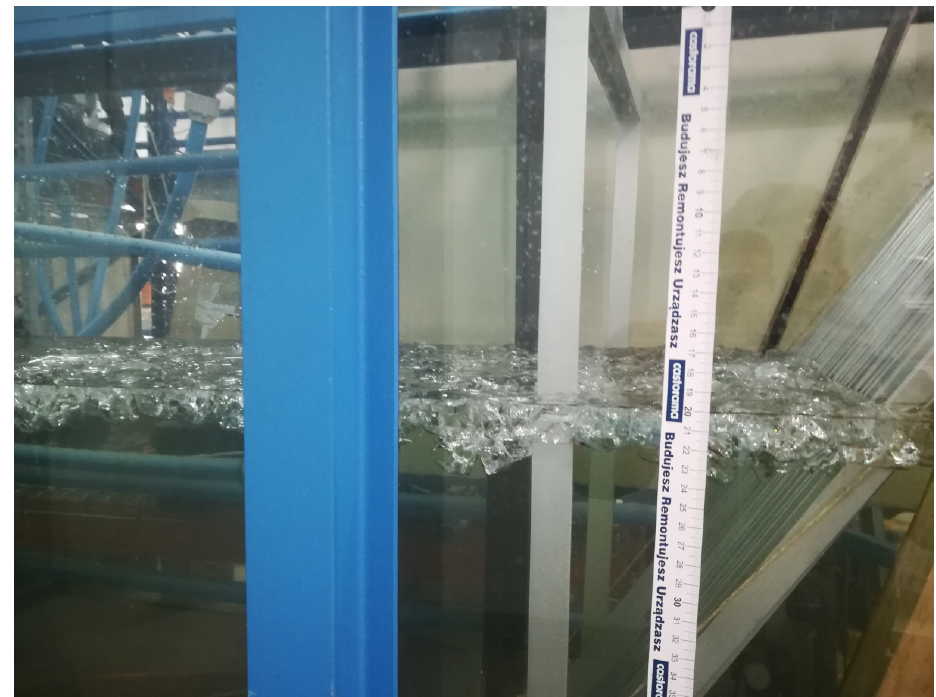
Figure 6. Ice jam, 6 kg ice variant. Table 1. Average values of flow rate, drag force and drag coe ffi cient.